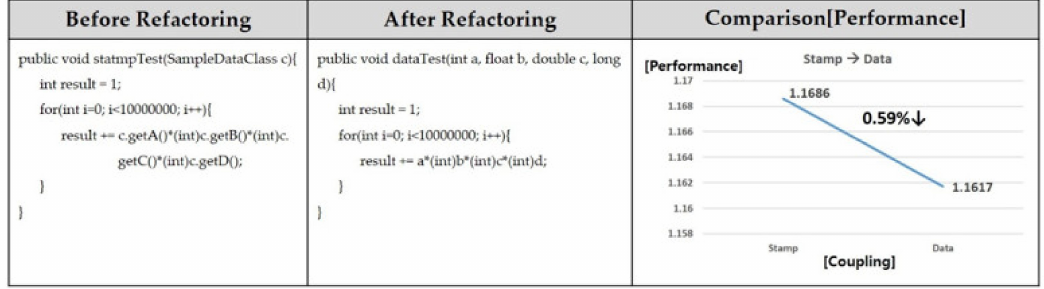
Figure 11. Enhancement of performance after refactoring stamp into data